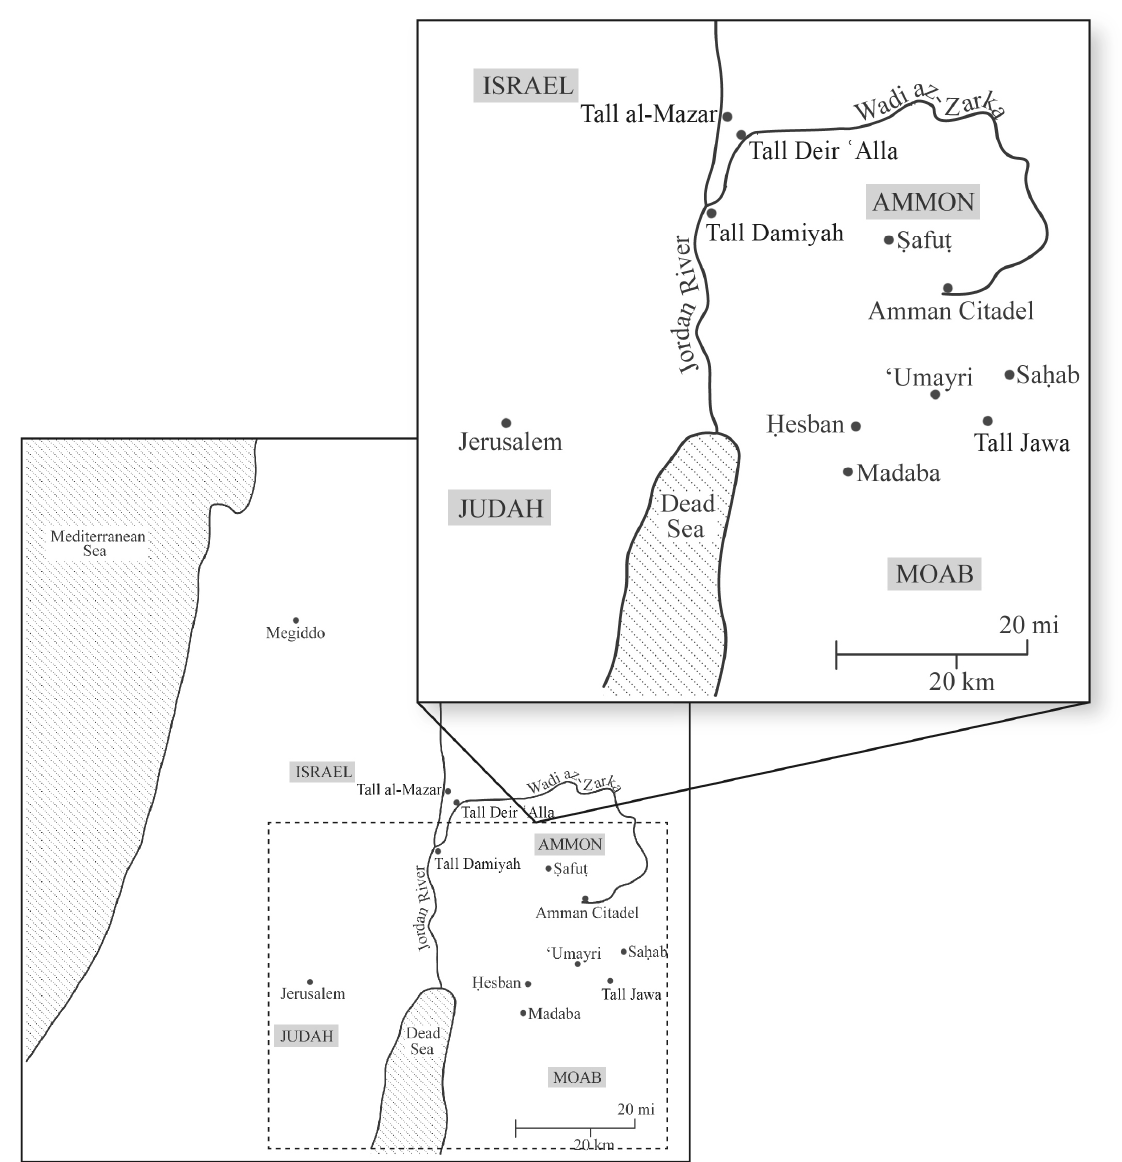
Figure 1. Map of Iron Age II Ammon.